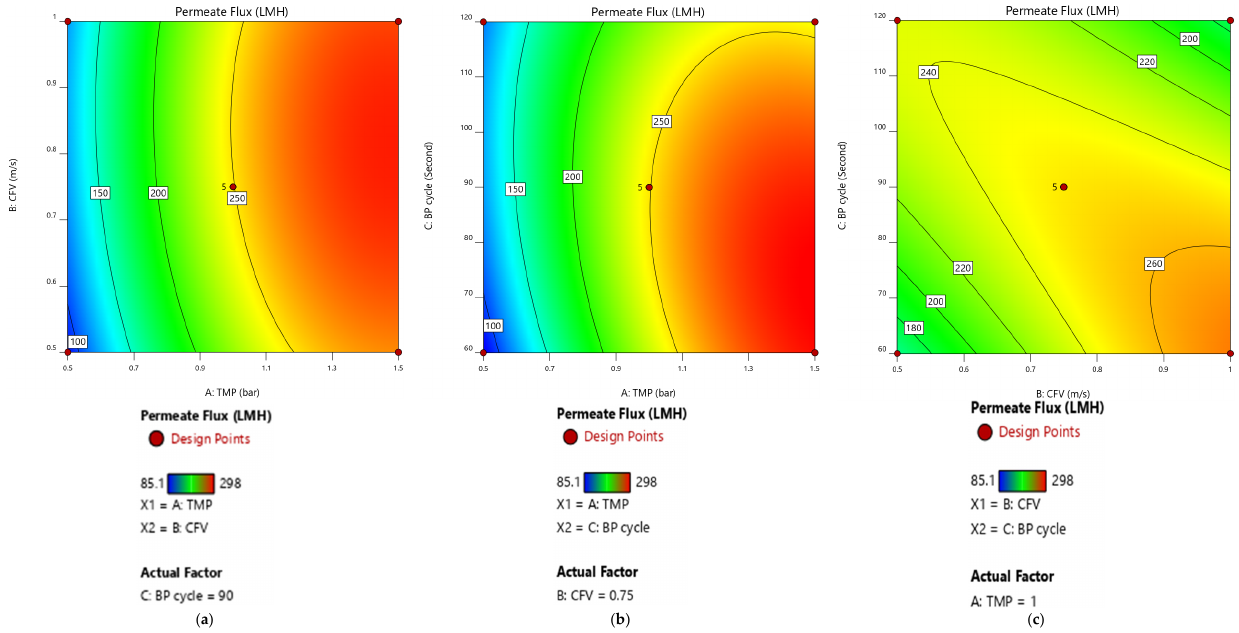
Figure 6. Response surface plot of membrane permeate flux as a function of the independent factors. ( a ) A: TMP and B: CFV at BP cycle= 90 sec. ( b ) A: TMP and C: BP cycle at CFV= 0.75 m/s. ( c ) B: CFV and C: BP cycle at TMP = 1 bar.